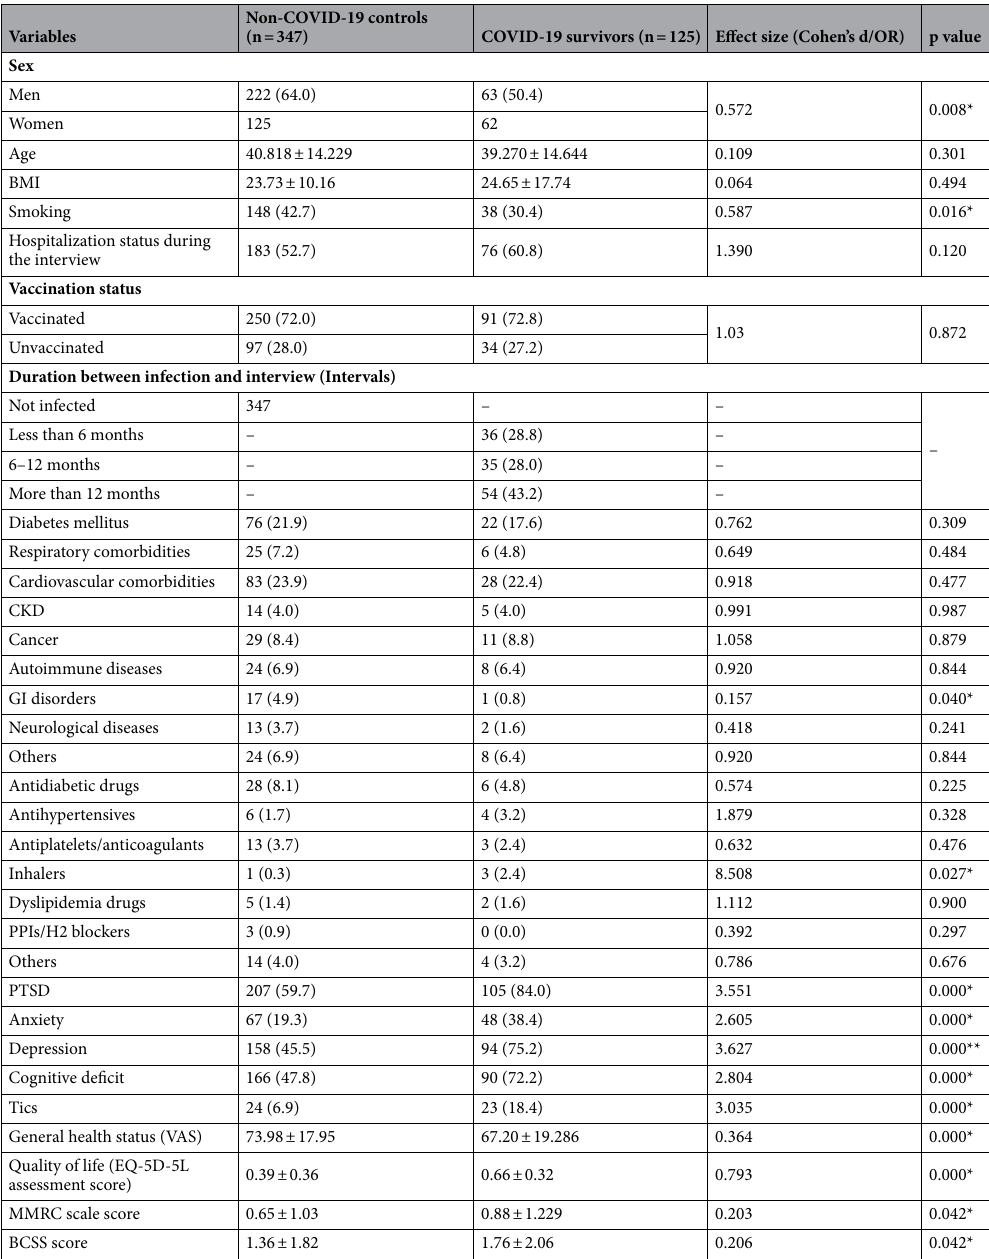
Table 1. The characteristics of COVID-19 survivors and non-COVID-19 cohorts. This table shows the differences between COVID-19 survivors and non-COVID-19 patients in terms of general characteristics and outcomes. *P value < 0.05. BMI Body mass index, COPD Chronic obstructive pulmonary disease, OSA Obstructive sleep apnea, HTN Hypertension, HF Heart failure, IHD Ischemic heart disease, CKD Chronic kidney disease, CVAs Cerebrovascular diseases, ACEI Angiotensin-converting enzyme inhibitor, ARB Angiotensin receptor blocker, CCB Calcium channel blocker, PPIs Proton pump inhibitors, ACH Acetyl choline, PTSD Posttraumatic stress disorder, VAS Visual Analogue Scale, EQ-5D-5L EuroQol 5-dimension 5-level assessment, MMRC Modified Medical Research Council scale, BCSS Breathlessness, Cough, and Sputum